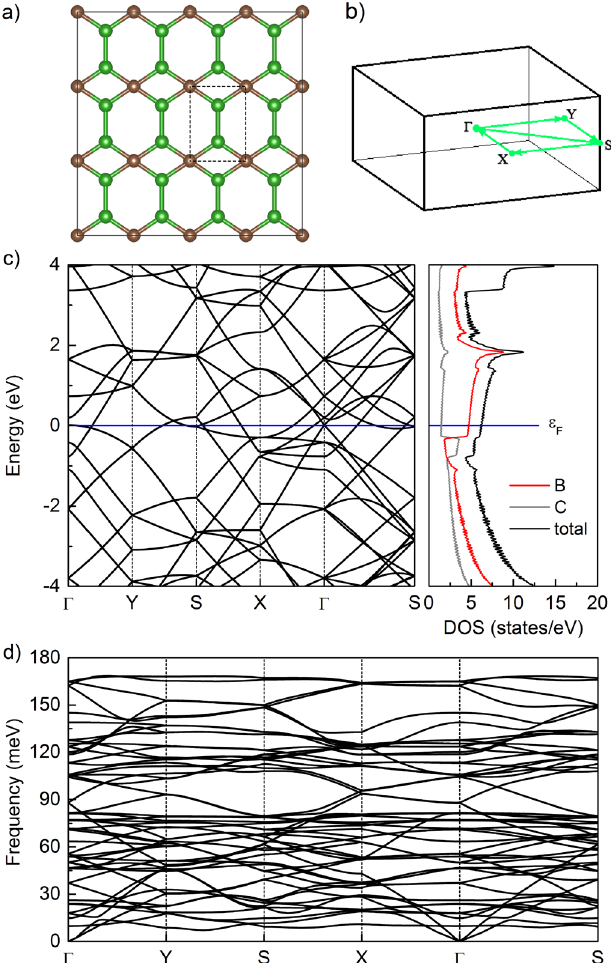
Figure 1. ( a ) Optimized structure of 4 × 3 supercell of B 2 C with the rectangle indicating the unitcell. Green for B, brown for C. ( b ) The Brillouin zone for P2mm structure with special k-point paths. ( c ) The electronic band structure of B 2 C supercell along the Ŵ -Y-S-X- Ŵ -S high-symmetry line, together with the total and partial density of states. The Fermi level ε F is set to zero. ( d ) Phonon-dispersion relations of pristine B 2 C